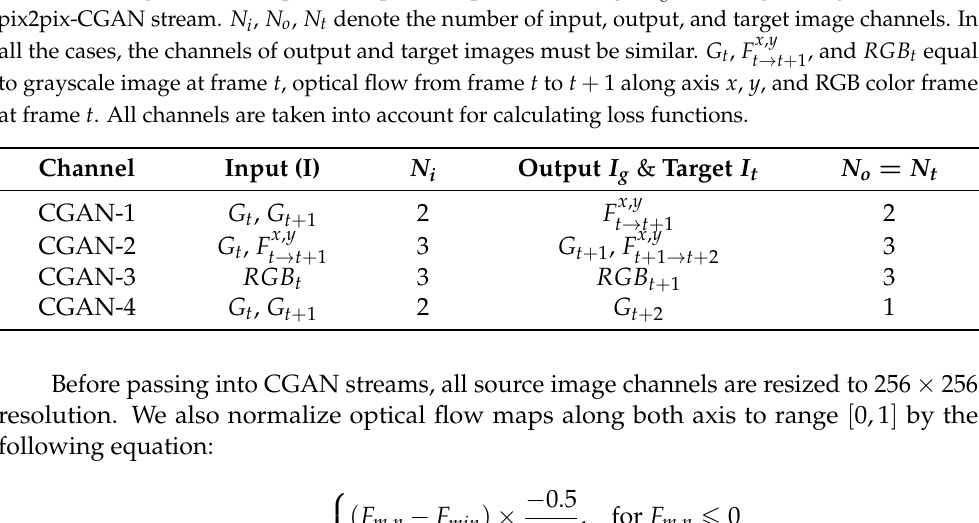
Table 1. Configuration of input I , output (i.e., predicted images I g ) and target images I t for